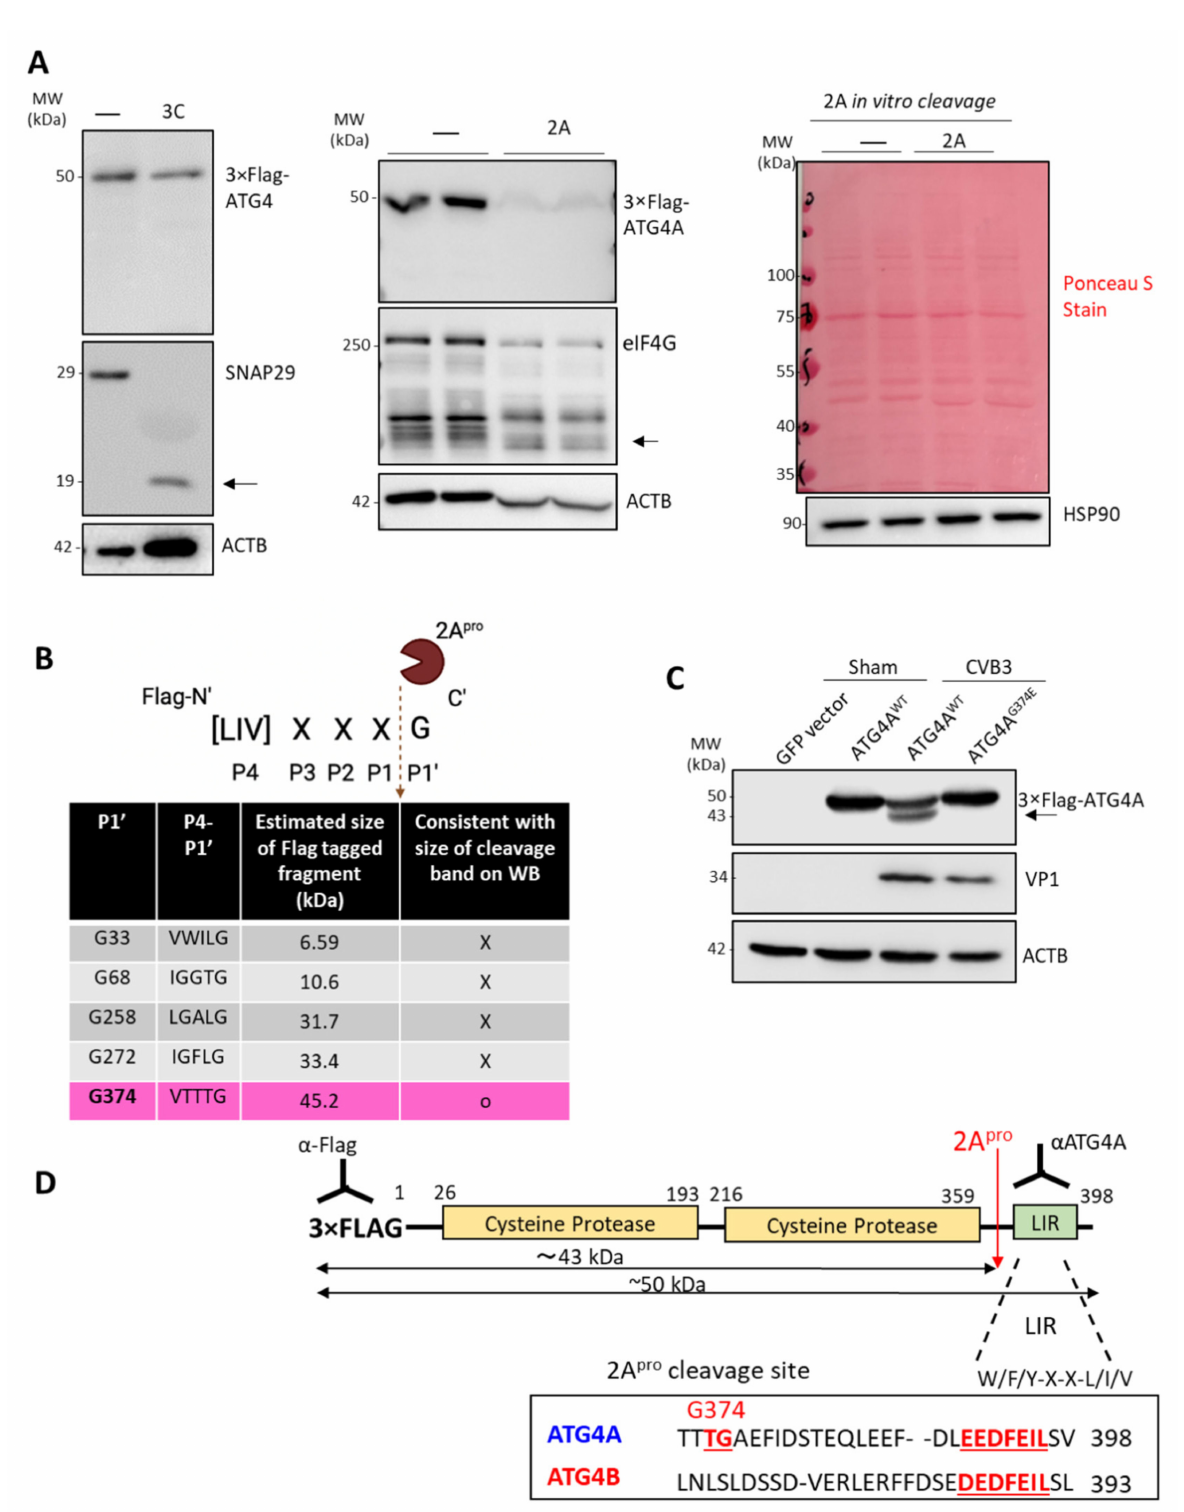
Figure 2. ATG4A is cleaved by viral protease 2A before glycine 374. ( A ) In vitro cleavage assay was performed with no protease control, purified viral protease 3C ( left ) or 2A ( middle ) in the presence of Flag-ATG4A. SNAP29 and eIF4G were used as a positive control for 3C and 2A activity, respectively. Membranes from 2A in vitro cleavage ( middle ) were stained with Ponceau S Stain or immunostained with anti-HSP90 antibody to probe total protein and alternative loading control respectively. ( B ) Illustration of the potential cleavage sites in the open reading frame of